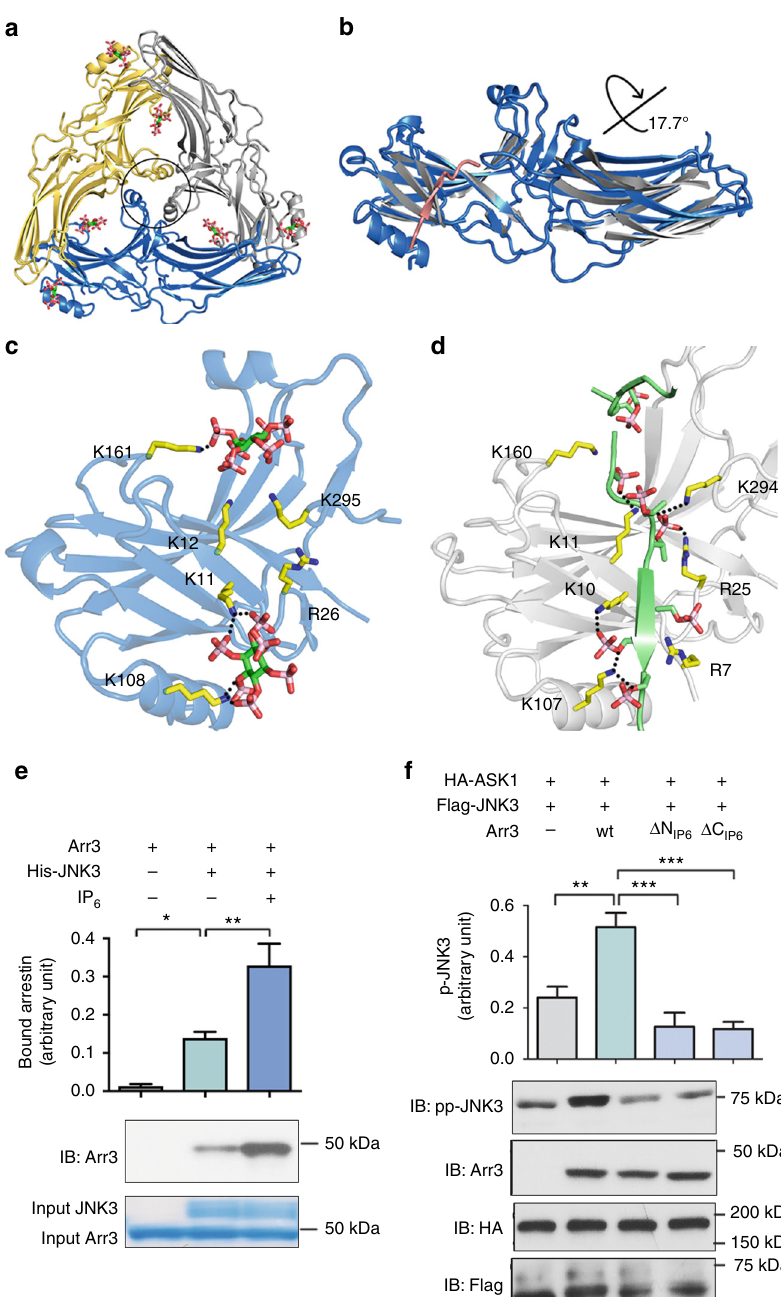
Fig. 1 The structure of IP 6 -activated arrestin-3. a Ribbon diagram of the IP 6 -activated arrestin-3 (Arr3) trimer. Each protomer is shown in a different color (gray, yellow, blue); IP 6 is shown as sticks. Finger loops are circled. b Overlay of the N-domain of IP 6 -activated (blue) with basal arrestin-3 (gray with a pink C-tail, PDB 3P2D 6 ) highlights the 17.7° inter-domain rotation. c IP 6 binding sites within the phosphate sensor on the arrestin-3 N-domain. d Phospho- peptide binding sites within the phosphate sensor on arrestin-2 N-domain (PDB entry 4JQI 11 ). e Arrestin-3 binding to puri fi ed His 6 -JNK3 immobilized on Ni-NTA resin in the presence or absence of 100 µ M IP 6 ( n = 8). The quantity of bound arrestin-3 was measured by densitometry (mean ± SEM) and compared using one-way ANOVA. * p ≤ 0.05; ** p ≤ 0.01. f Measurement of JNK3 activation by arrestin-3 and mutants of the IP 6 binding sites. JNK3 activation (mean ± SEM) was assessed by measuring the phospho-JNK3 (ppJNK3) level in HEK293 cells co-transfected with HA-ASK1, Flag-JNK3 and either empty vector, arrestin-3, the Δ N IP6 arrestin-3 (R8Q, K11A, K12A, K108Q, K161Q, K295Q) or the Δ C IP6 arrestin-3 (K233Q, R237Q, K251Q, K325Q, K327Q). The assay was repeated three times and JNK3 phosphorylation was compared using one-way ANOVA. ** p ≤ 0.01, *** p ≤ receptor-independent signaling and had no global signaling AlexaFluor C5 maleimide dye, titrated IP 6 into fl uorophore- defect. labeled arrestin-3, activated with an infrared laser, and monitored To determine whether arrestin-3 binds IP 6 at the concentra- the fl uorescence intensity. MST allowed us to obtain binding tions found in cells, we used microscale thermophoresis (MST) to curves and calculate equilibrium dissociation constants. Wild-type measure binding af fi nity. We labeled wild-type arrestin-3 with arrestin-3 exhibits two binding af fi nities for IP 6 (K D = 57 nM and